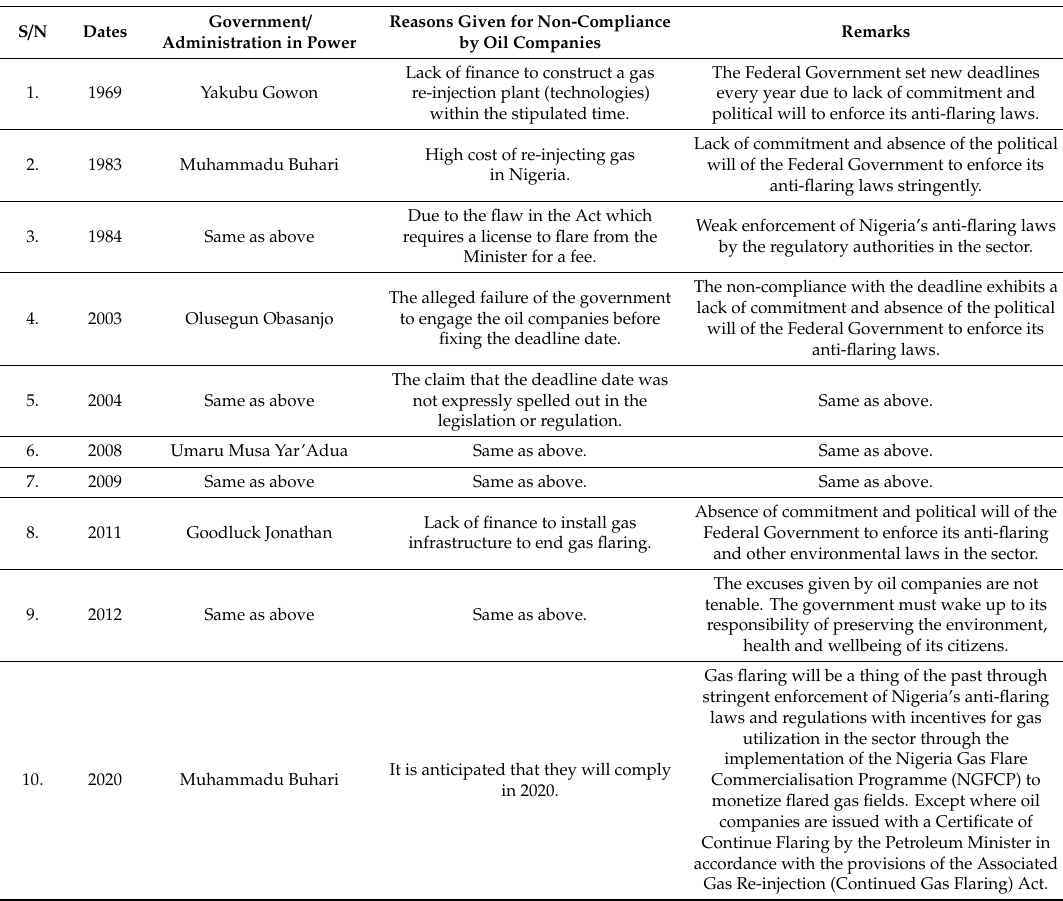
Table 3. Some Selected Dates Previously Fixed to End Gas Flaring in Nigeria by the Federal